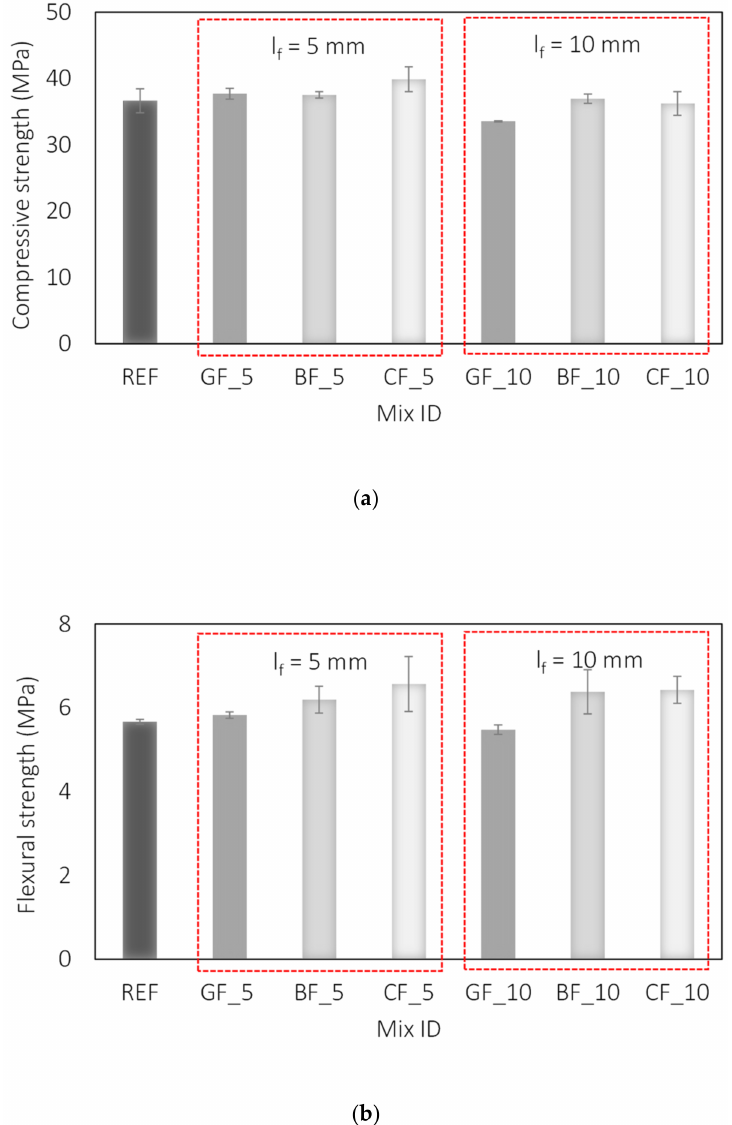
Figure 4. Influence of fibre type and length on: ( a ) compressive strength, ( b ) flexural strength of fibre reinforced